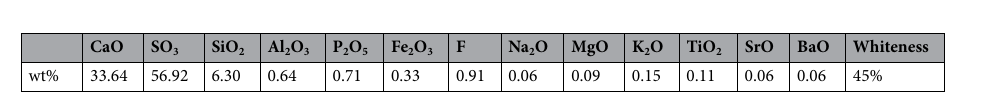
Figure 2. SEM photograph and XRD pattern of PG.